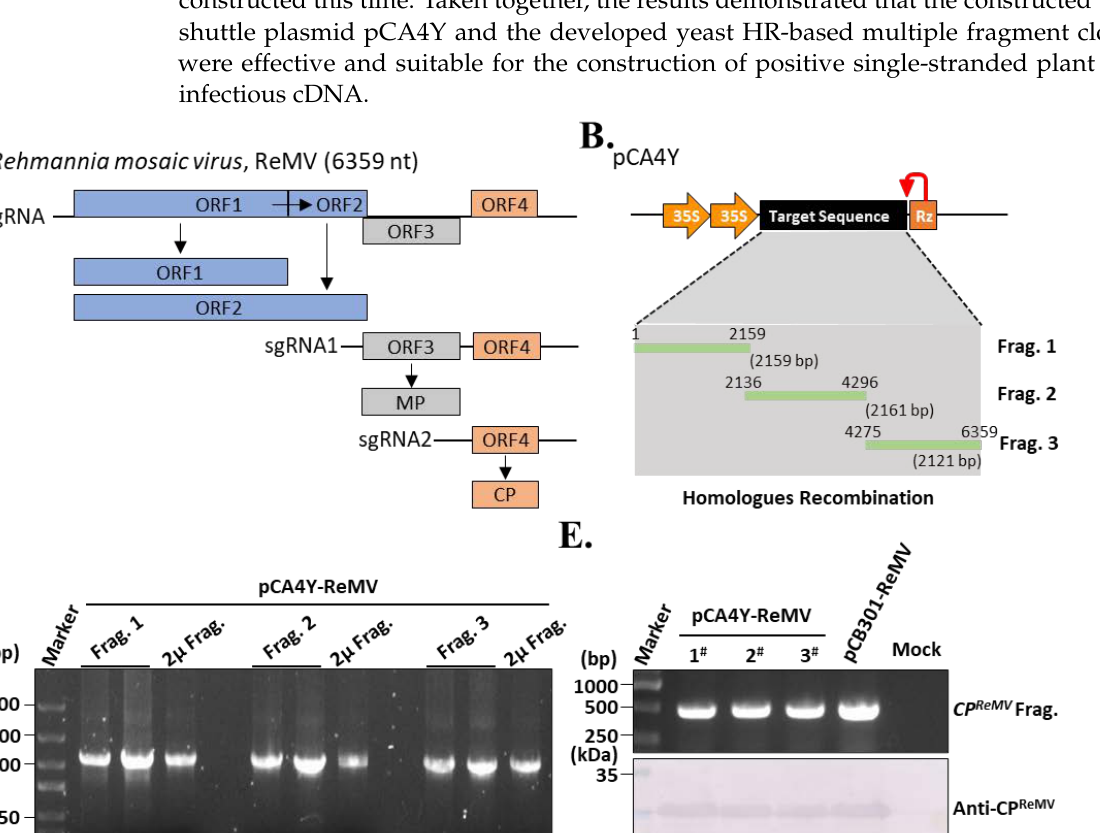
Figure 5. Construction of the Rehmannia mosaic virus (ReMV) infectious cDNA clone using the established triple-shutting vector-based yeast HR recombination. ( A ). Genome organization of the ReMV. The coding strategies were similar to the YoMV described in Figure 4A. ( B ). Illustration of the detailed construction strategies for the ReMV single cDNA. The cDNA was divided into three parts: fragments 1 is 2,159 bp (Frag. 1), fragment 2 is 2161 bp (Frag. 2), and fragment 3 is 2121 (Frag. 3). ( C ). PCR validation of the positive ReMV infectious cDNA clone with specific pairs of primers listed in Supplementary Table S1. The detailed meaning of the Frag. 1, Frag 2, and Frag. 3 were shown in ( B ). ( D ). Symptoms of the ReMV infectious cDNA clones-inoculated N. benthamiana plants after 5 dpi. The pCB301-ReMV-inoculated plants were treated as positive control. The mock, and numbers shown were the same meaning in Figure 4D. Bar indicates 3 cm. ( E ). RT-PCR and Western blot detect the infectivity of the newly constructed ReMV infectious clones. Specific pairs of primers and antibodies for the CP ReMV coding gene and protein were used in the assays, respectively. 3. Discussion